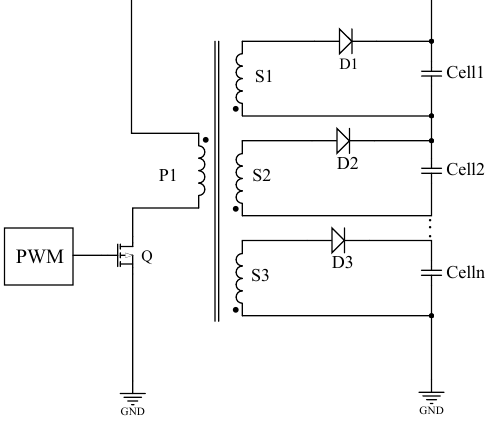
Figure 3. Multi winding transformer balancing